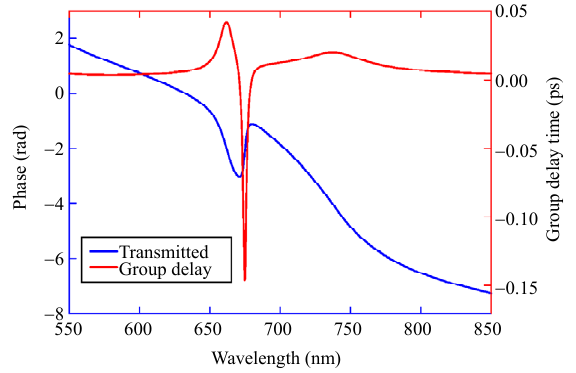
Fig. 3 Variations of the transmitted phase and the group delay time with respect to the wavelength of incident